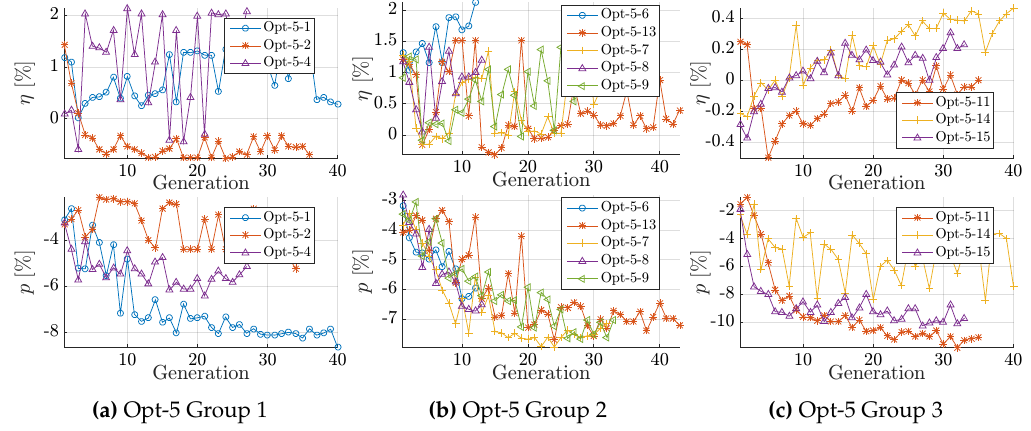
Figure A6. Analysis of the constraint violation in Group 2, with respect to the total number of solutions in each optimisation case. ( a ) Opt-5 Group 1; ( b ) Opt-5 Group 2; ( c ) Opt-5 Group 3.